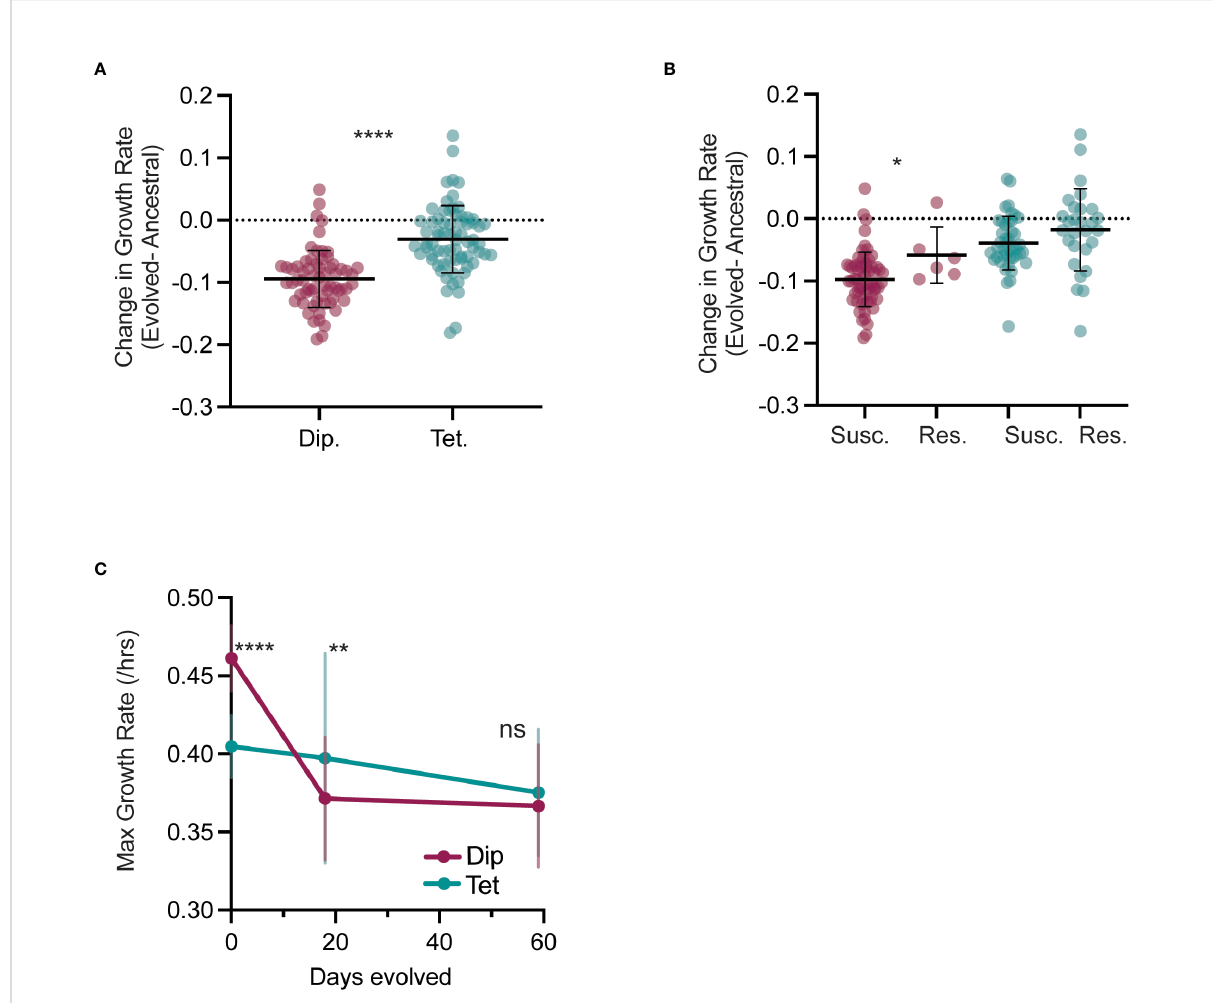
FIGURE 5 Tetraploids have lower fi tness costs in the absence of caspofungin. (A) The change in growth rate (D59-D0) for each diploid (maroon) and tetraploid (teal) evolved line is plotted, with the black horizontal lines representing the mean, and vertical lines representing the SD. Each symbol represents the average of two replicate experiments. Statistical comparison between diploid and tetraploid is represented by Mann-Whitney U- test (****p < 0.0001). (B) The change in growth rate (D59-D0) for each sensitive and resistant diploid (maroon) and tetraploid (teal) evolved line is plotted, with the black horizontal lines representing the mean, and vertical lines representing the SD. Each symbol represents the average of two replicate experiments. Statistical comparison is between sensitive and resistant populations of the same ploidy and is represented by Mann- Whitney U-test (**p<0.01). (C) Mean and SD growth rates of diploid (maroon) and tetraploid (teal) evolved lines at day 0, 18 and 59. Statistical comparison is between average diploid and tetraploid growth rate form the same day and is represented by Mann-Whitney U-test (****p < 0.0001, **p <